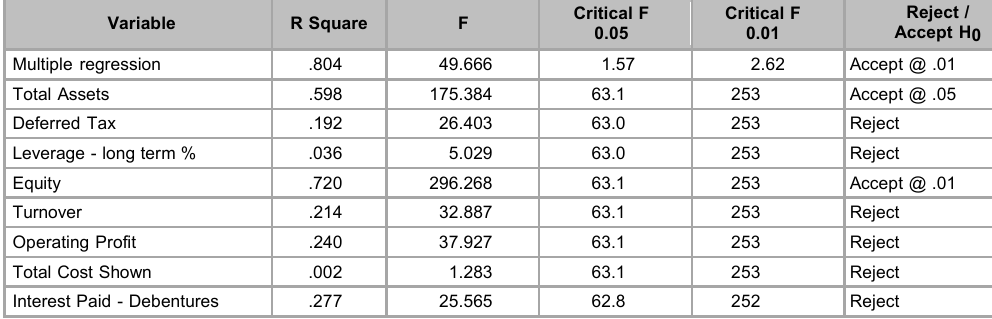
Comparison of simple regression to multiple regression